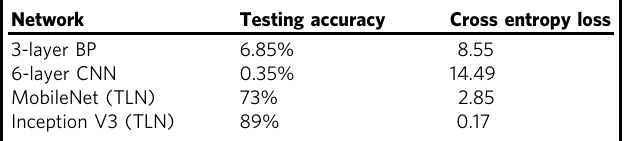
Table 4 The performances of different neural